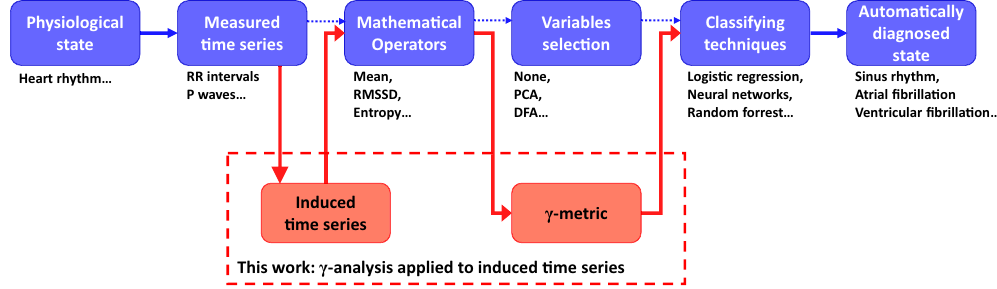
Figure 1. Classic physiology automatic decision flow chart process: Standard steps of the usual approach to physiological state automatic classification are shown as blue boxes. Only some examples are given for each step according to the focused arrhythmia problem. The contribution of this work is highlighted in the dashed red box and consists of applying the γ -analysis, a simple method we developed to easily screen many potential discriminant variables through calculation of the γ -metric for an extended set of state variables generated by the calculation of induced time series (time derivative of a measured RR interval time series). The red boxes and red arrows show that the positioning of our proposal is complementary to the typical steps of the automatic decision flow chart process in